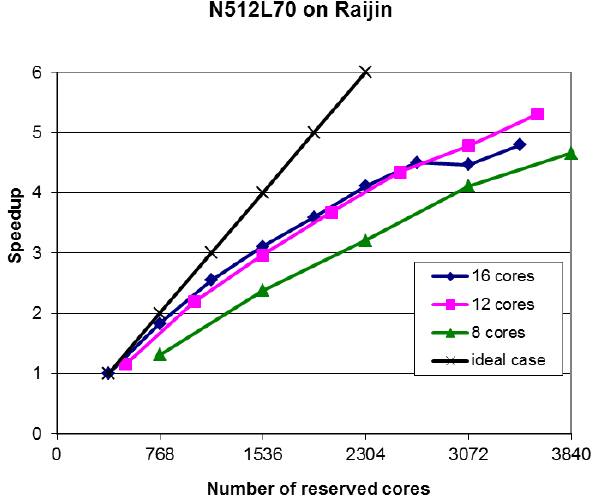
Figure 9. Speedup as a function of number of reserved cores on Raijin. Speedup was calculated in relation to the elapsed time of 2881s obtained for a 384-core run on fully committed nodes.